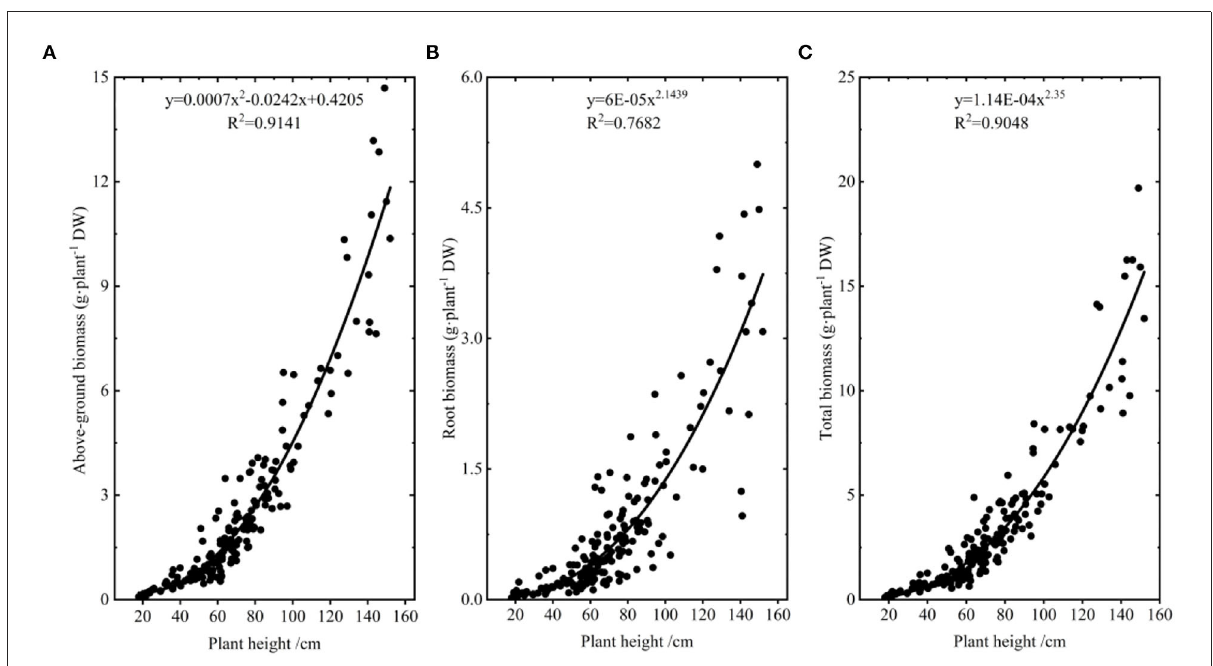
FIGURE2 The biomass model of A. selengensis . (A) The aboveground biomass model. (B) The root biomass model. (C) The total biomass model.